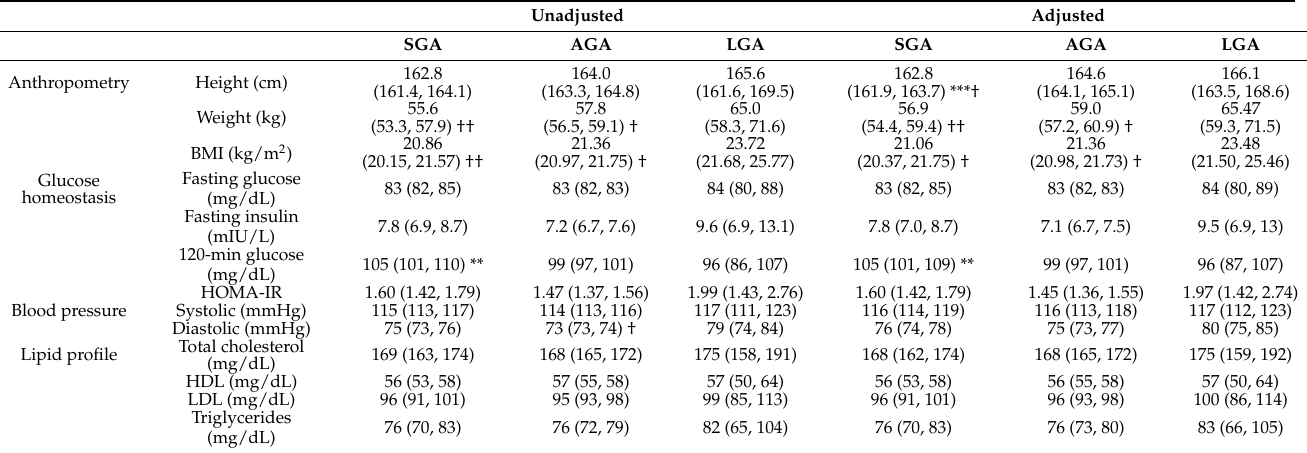
Table 2. Anthropometric and cardiometabolic outcomes in our cohort of young adults in Thailand according to birth weight